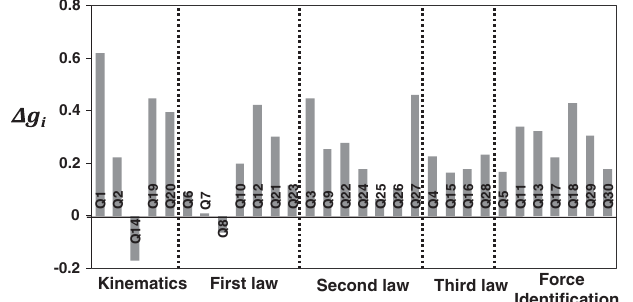
FIG. 2. Conventional analysis of differences in student perfor- mance on the individual FCI items between the PRTC course and − g the M&I course: Δ g ¼ g . Here, each g represents an PRTC M & I item normalized